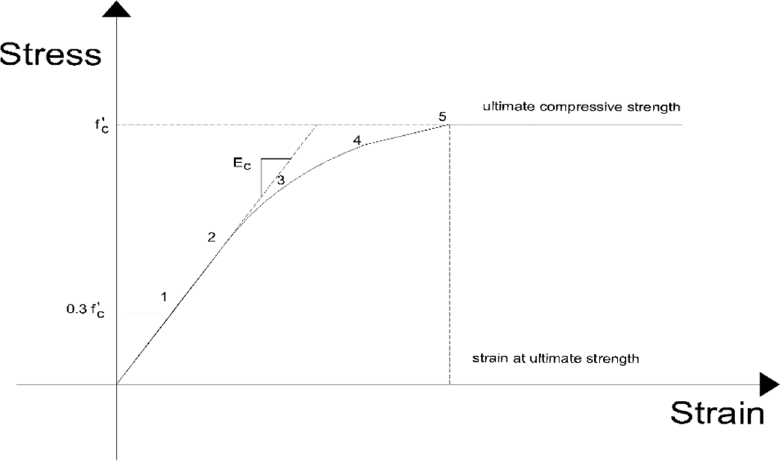
Figure 6. Simplified compressive Uniaxial stress-strain curve for concrete (Adapted from Refs. [19,20]).